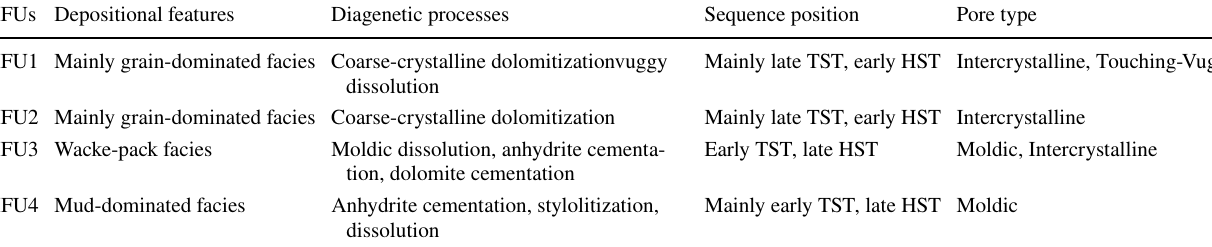
Table 2 Depositional, diagenetic, sequence positions, pore type and petrophysical attributes of hydraulic flow